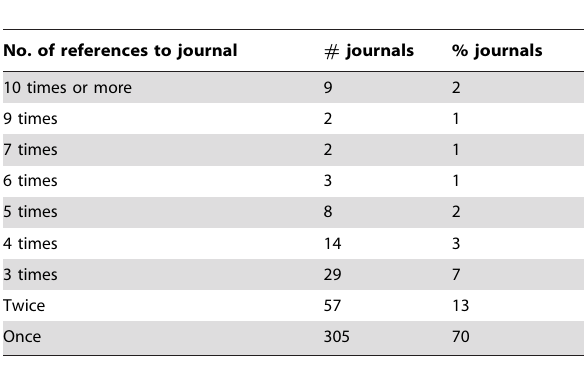
Table 3. Number of references per journal cited in the 5 most recent blog posts for the 126 blogs.